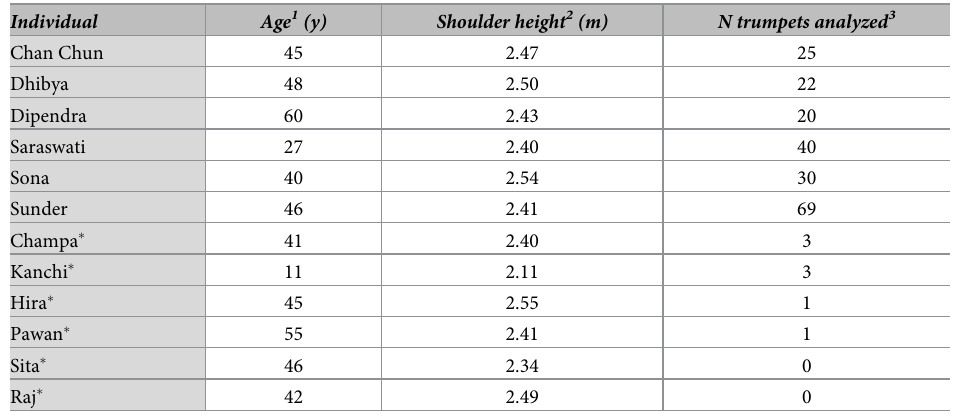
Table 1. Study subjects and collected data.